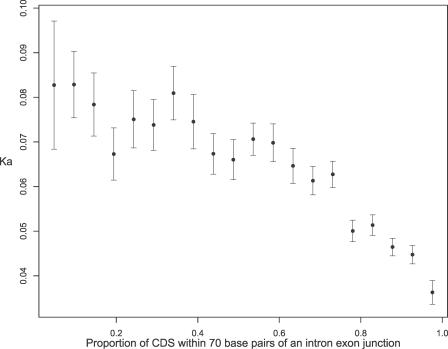
The Relationship between K
A in the Mouse–Human Comparison and the Proportion of Sequence within 70 bp of an Exon–Intron JunctionError bars show standard error of the mean. CDS, coding sequence.